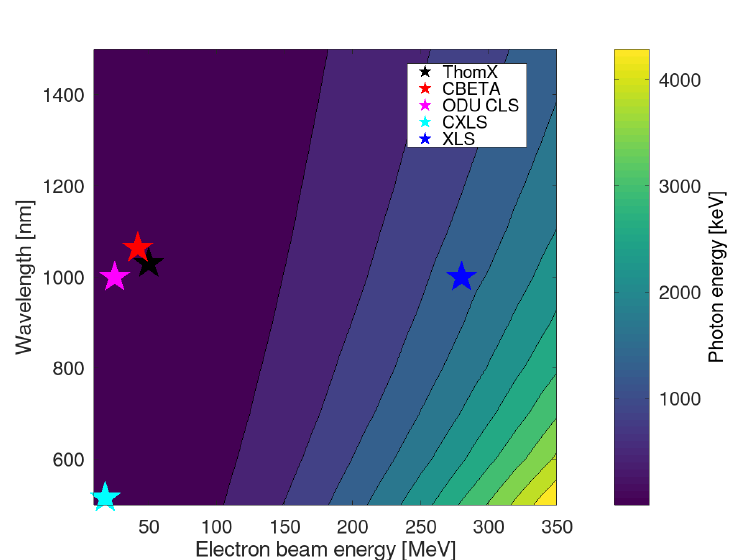
Figure 8. Parametric scan of the photon energy obtained by varying the laser wavelength and electron beam energy. The maximum photon energies of various sources are included, along with the proposed XLS-based source. Scans of bandwidth and flux in a 1.5 mrad cone were computed in Figure 9 for the XLS-based source. The obtained bandwidth maps showed a decrease of up to 4% for a lower electron beam energy of 100 MeV, and an electron beam size larger than 4 µm.